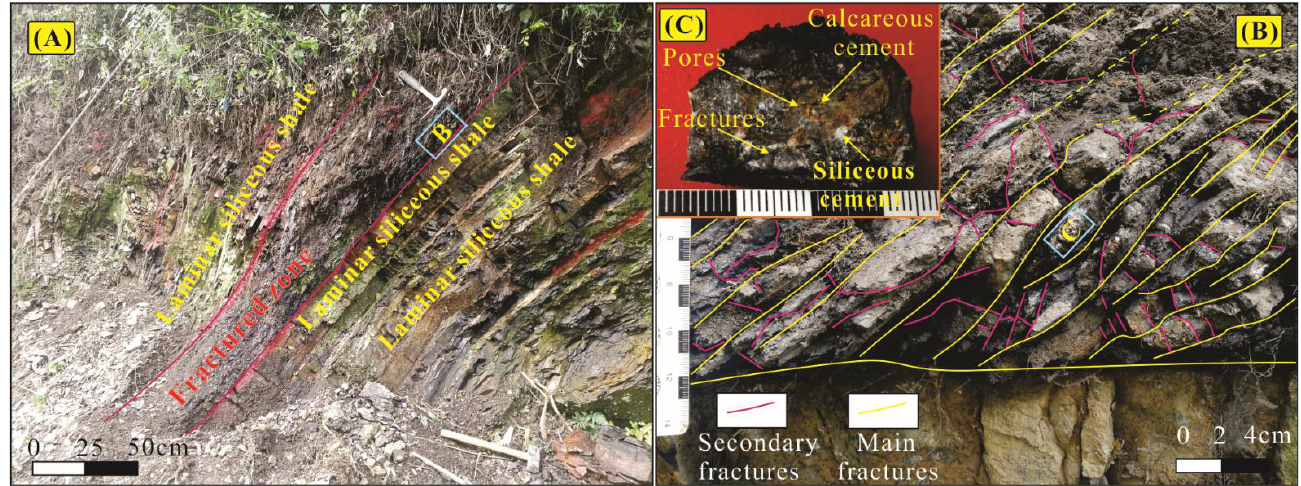
Figure 9. Fabric of the fracture zones in the Wufeng Formation. ( A ) Fracture zones are interlayered with laminar siliceous shale; ( B ) the orientation of the main fractures is obviously controlled by shear stress, whereas the secondary fractures are oriented randomly; ( C ) fault breccia containing some pores and fractures that are partially sealed by siliceous and calcareous cements.